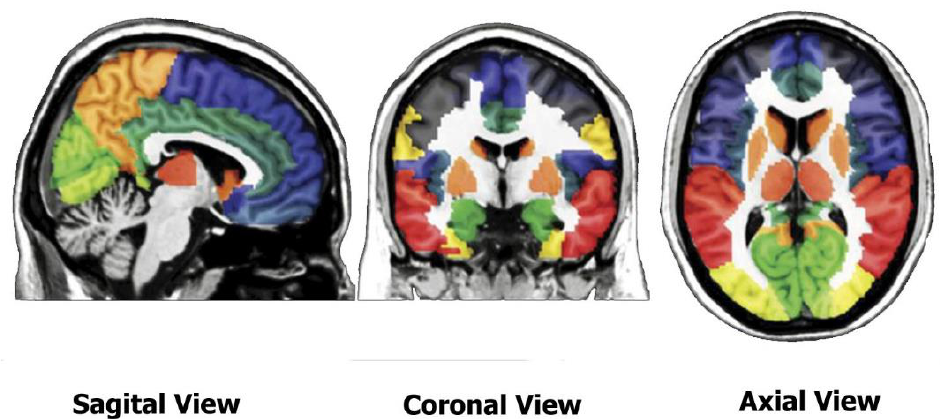
Figure 2. Automatic Anatomical Labeling (AAL) atlas. Di ff erent regions of brain are in di ff erent colors.